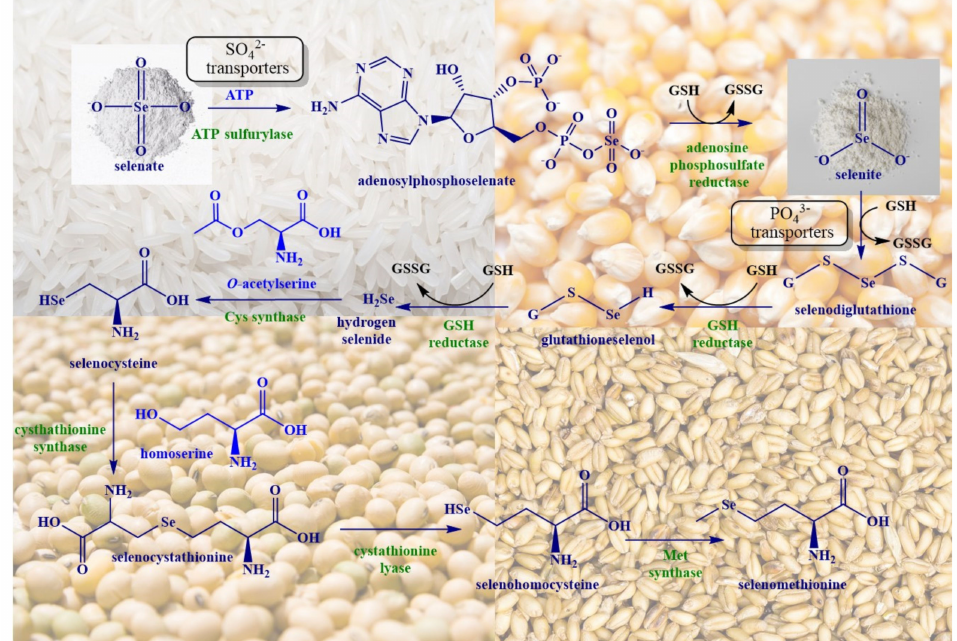
Figure 1. Biosynthesis of SeMet in plants involves the uptake of SeO 42 − via SO 42 − transporters and its interaction with ATP to produce adenosylphosphoselenate, which is reduced to SeO 32 − by adenosylphosphosulfate reductase. SeO 32 − , either absorbed via PO 43 − transporters or reduced from SeO 42 − , is further reduced to selenide by GSH via intermediates such as selenodiglutathione and glutathioneselenol. The interaction of selenide with O -acetylserine results ultimately in the formation of SeCys. Interaction of SeCys with homoserine in the presence of cystathionine synthase generates selenocystathionine which is cleaved enzymatically by cystathionine lyase to selenohomocysteine, pyruvate and ammonia. This is followed by the formation of SeMet from selenohomocysteine via methionine